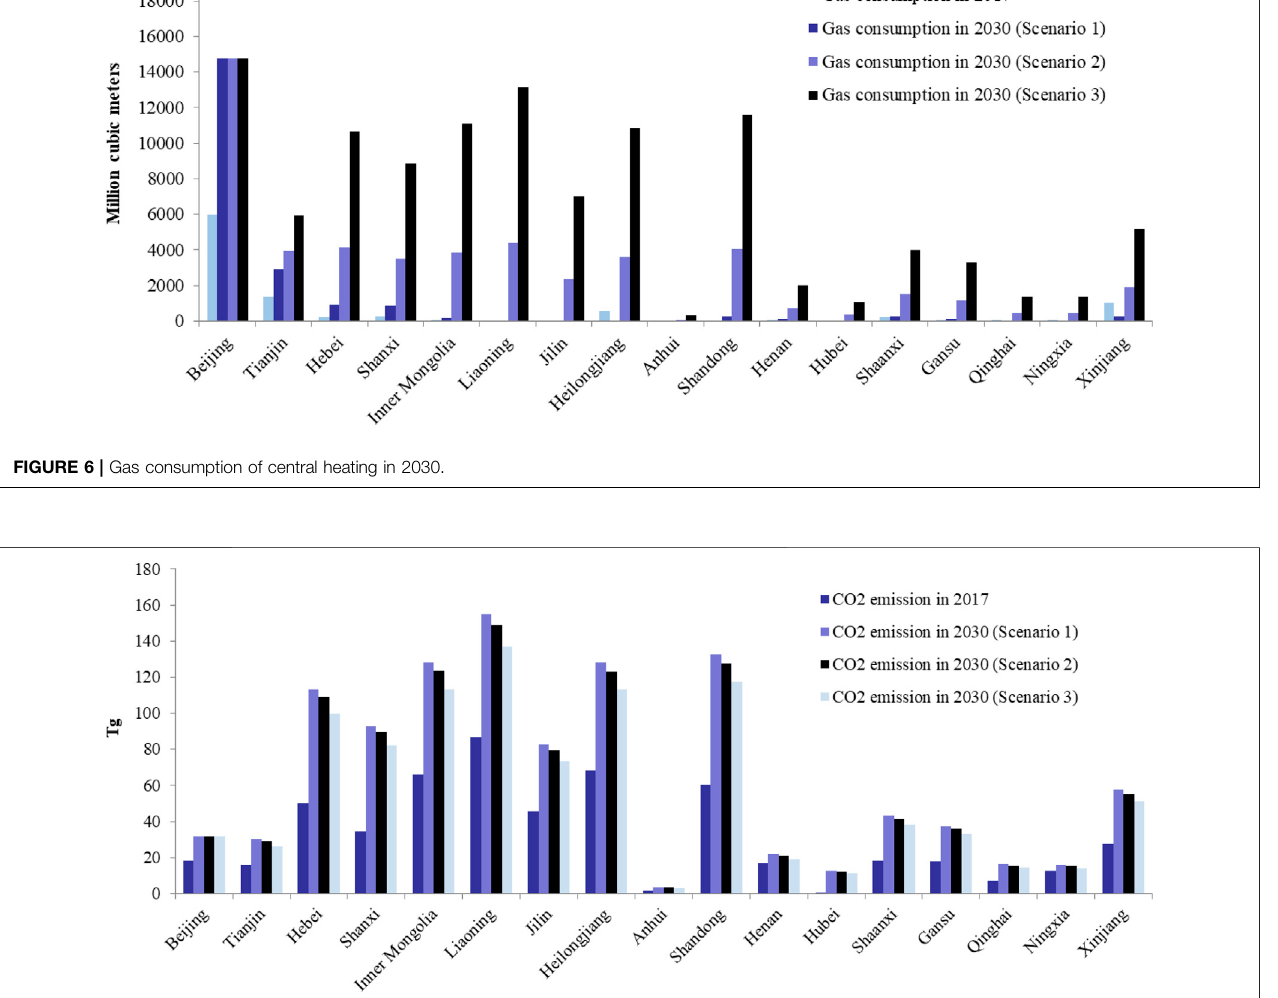
FIGURE 7 | CO 2 emissions of central heating in